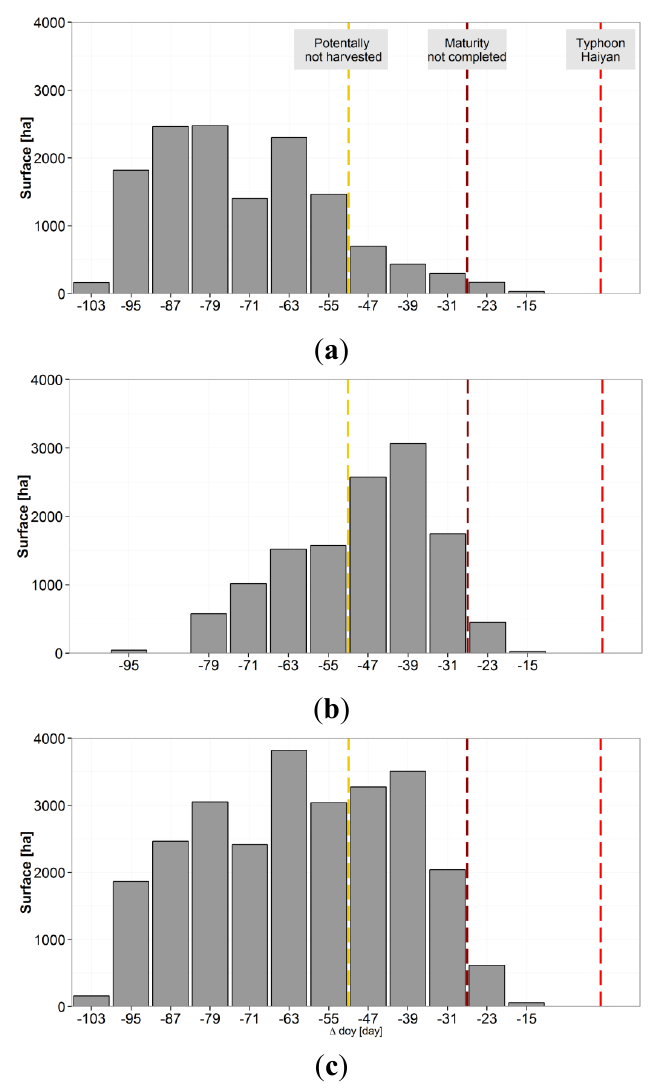
Figure 9. Distribution of rice area by time span ( ∆ − in days) between the MODIS (cid:2186)(cid:2197)(cid:2207) estimated heading date and the typhoon occurrence in Leyte for the 2013 wet season. Northwestern and northeastern rice areas are reported in panels ( a ) and ( b ), respectively. Panel ( c ) provides the results for the entire study area. Vertical dashed lines are 30 (brown) and 50 (yellow) days before the typhoon date (red